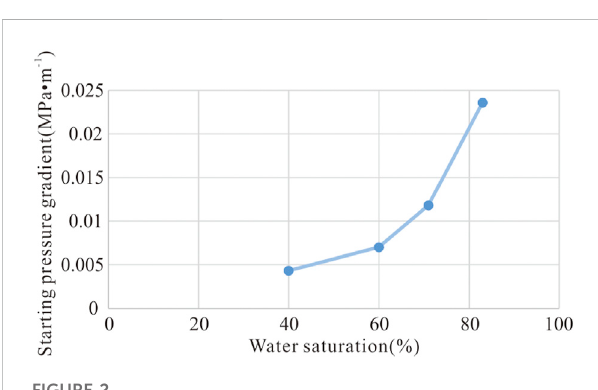
FIGURE 2 Starting pressure of typical medium, shallow gas reservoirs in western Sichuan under different water saturation conditions (Zhan et al., 2022).